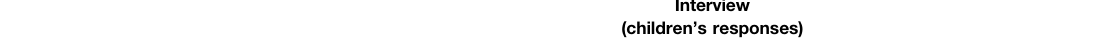
TABLE 2 | Children ’ s response in the interview based question.